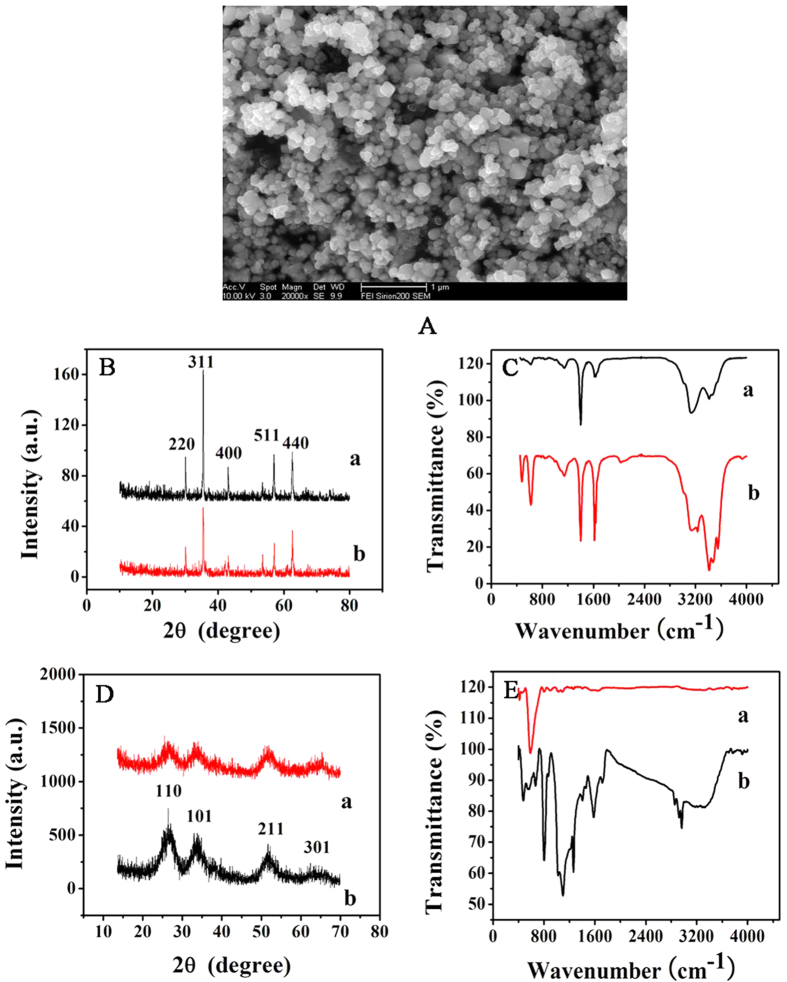
(A) SEM image of magnetite nanoparticles Fe3O4@APTES; (B) XRD spectra of (a) Fe3O4 and (b) Fe3O4@APTES; (C) FTIR spectra of (a) Fe3O4 and (b) Fe3O4@APTES; (D) XRD images of (a) GS-SnO2-PAN and (b) GS-SnO2; (E) FTIR spectra of (a) GS-SnO2-PAN and (b) GS-SnO2.